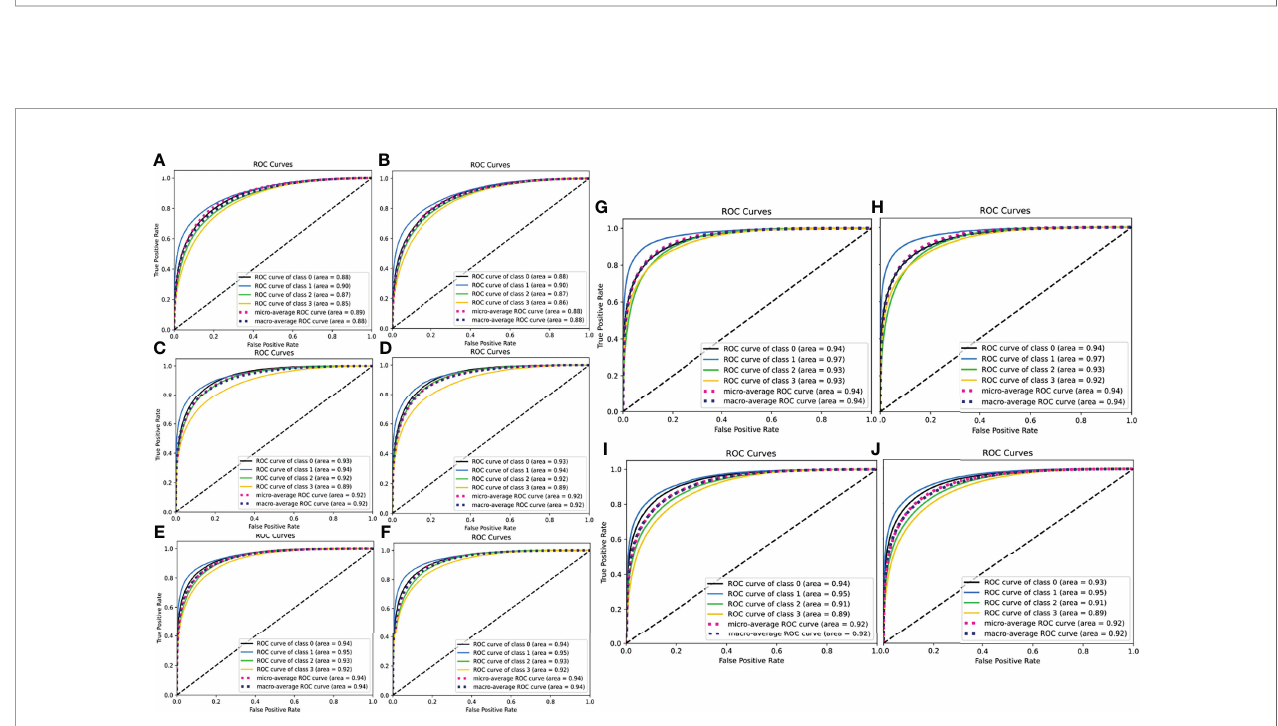
FIGURE 3 | ROC-AUC curves for the true positive and false positive rate of all fi ve models (left panels for validation set, right panels for testing set). (A, B) ResNet50 model, (C, D) VGG16 model, (E, F) Xception model, (G, H) ResNet101 model, (I, J) ResNet101_imgnet model. In the individual legends, classes 0, 1, 2, and 3 represent basal-like, HER2-enriched, luminal A, and luminal B subtypes, respectively. The higher the AUC, the better the model in detecting true positives and producing fewer false